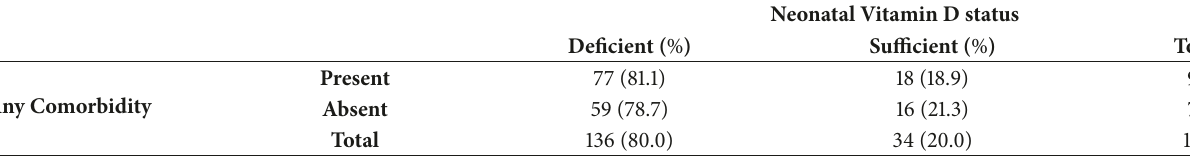
Table 4: Neonatal vitamin D status against neonatal